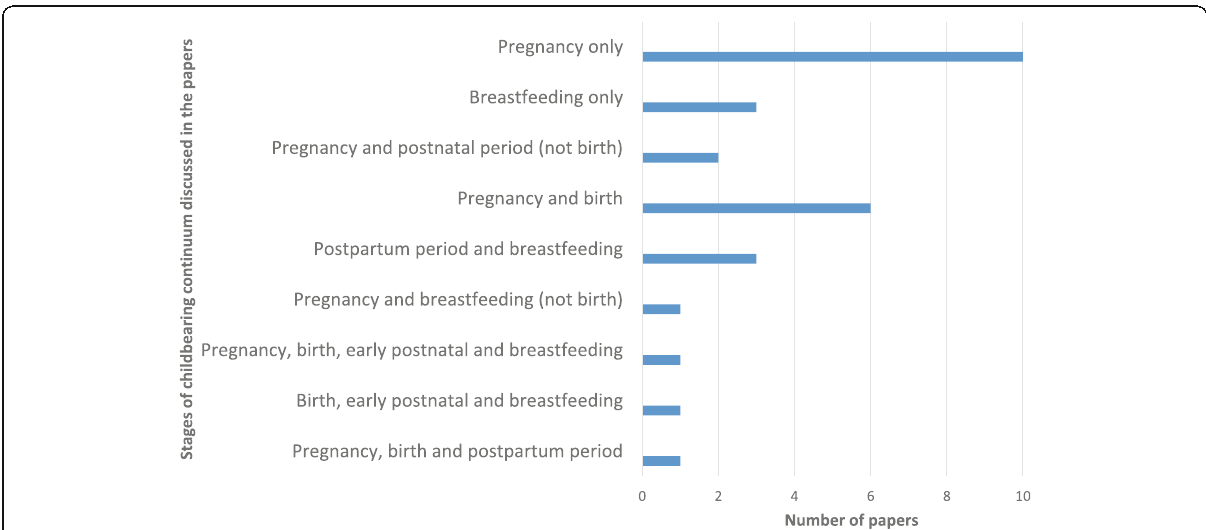
Fig. 2 Distribution of studies focussing on CMP use during different stages of the childbearing continuum ( n = 28) as identified by the first author